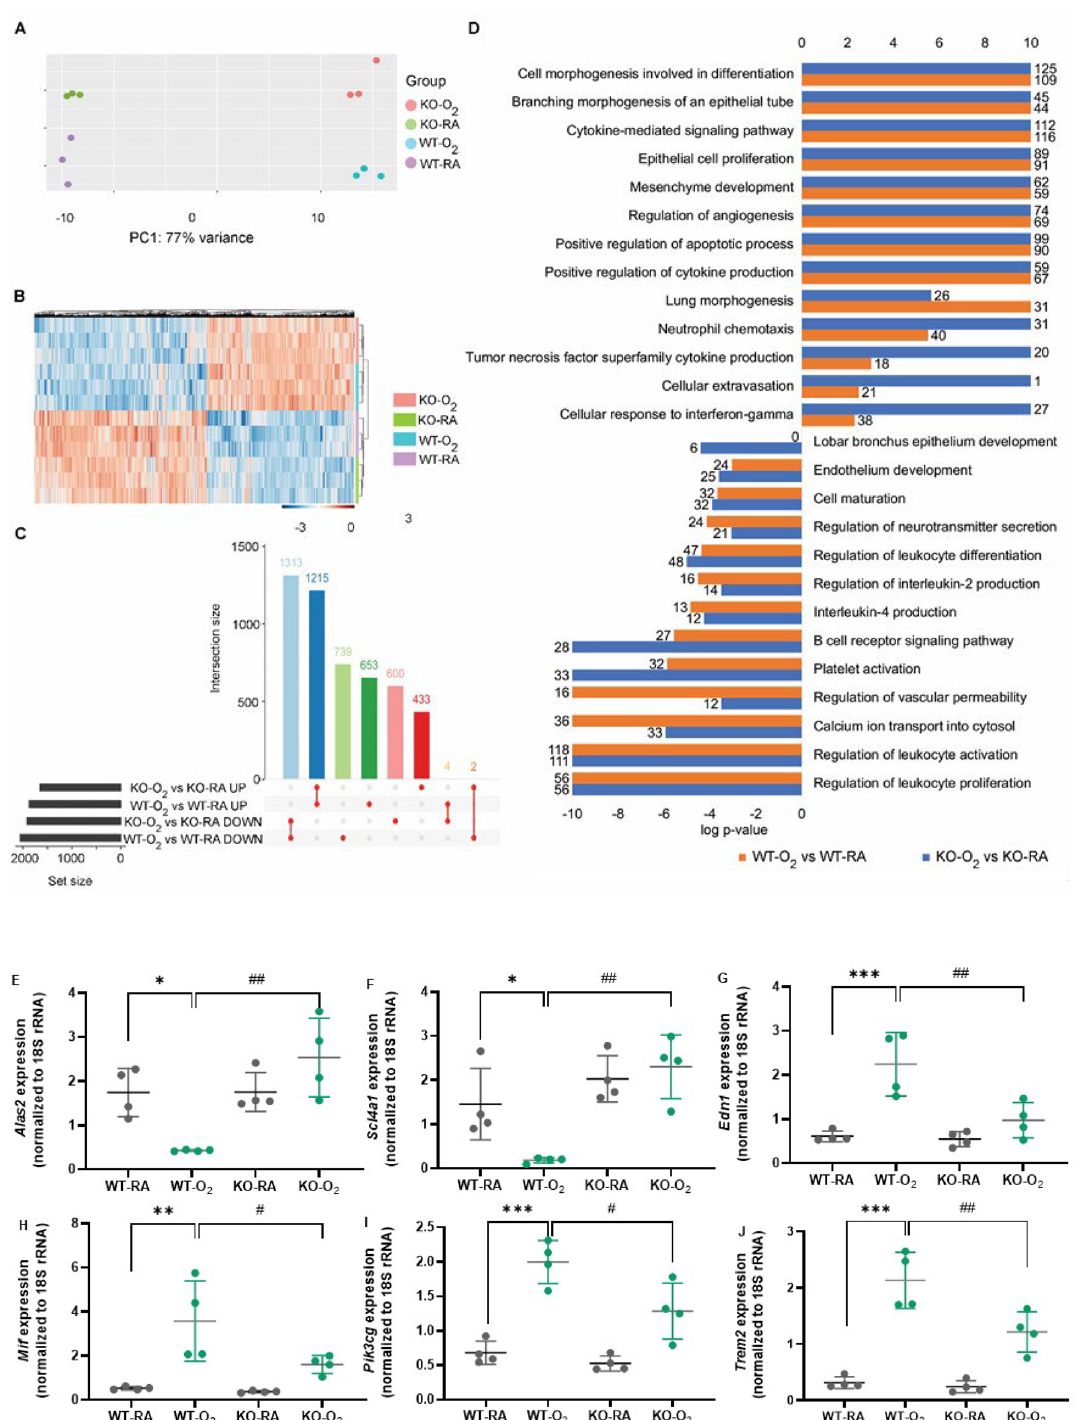
Figure 5. GSDMD-KO reduces hyperoxia modulation of inflammatory, tissue remodeling, and developmental pathways in the neonatal lung. ( A ) Principal component analysis (PCA) plot showing separation of WT and GSDMD-KO mice by PC1 and RA and O 2 animals by PC2. ( B ) Heatmap of differentially expressed genes in WT-O 2 vs WT-RA and KO-O 2 vs KO RA. ( C ) UpSet plot showing overlap of genes differentially regulated by hyperoxia in WT and GSDMD-KO lungs. Hyperoxia modulated the expression of 3926 genes in WT and 3567 genes in GSDMD-KO lungs. ( D ) Overrepresentation analysis using Toppcluster to identify similarities and dissimilarities of Gene Ontology terms and pathways modulated by hyperoxia in WT and GSDMD-KO lungs. Bars represent the log P-value, and the number of genes associated with each term is displayed at the end of the bar. In GSDMD-KO lungs, genes induced by hyperoxia were more strongly associated with TNF superfamily cytokine production, cellular extravasation, and cellular response to IFN-γ, while suppressed genes in GSDMD-KO were uniquely associated with lobar bronchus epithelium development and cell receptor signaling pathways. n = 3 animals/group. qRT-PCR validation of differentially expressed genes between hyperoxia-exposed WT and hyperoxia-exposed GSDMD-KO lungs included Alas2 ( E ), Scl4a1 ( F ), Edn1 ( G ), Mif ( H ), Pik3cg ( I ), and Trem 2 ( J ). n = 4/ group. * P < 0.05, ** P < 0.01, *** P < 0.001, WT-O 2 vs WT-RA. # P < 0.05, ## P < 0.01, WT-O 2 vs KO-O 2